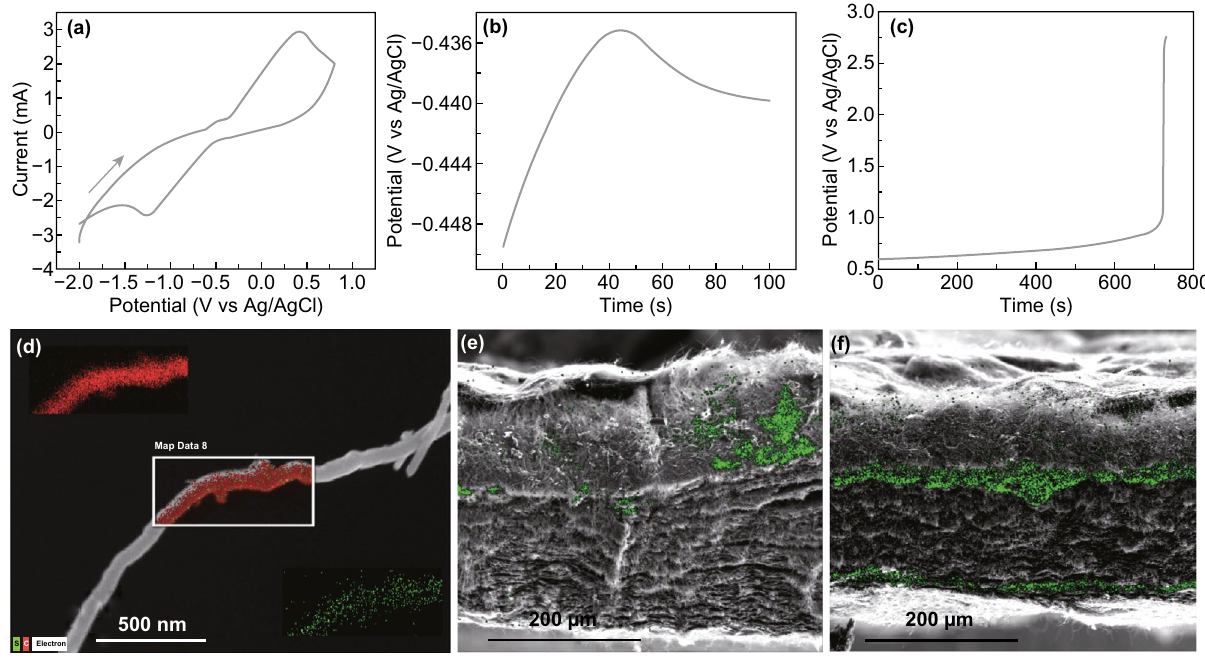
Fig. 1 a CV of 10 mM polysulfide using a BP electrode at 20 mV s −1 scan rate. Chronopotentiometry of sulfur electrodeposition on BP elec- trode at b 10 mA cm −2 and c 35 mA cm −2 . d EDS mapping of sulfur (green) and carbon (red) of a single nanotube of S/BP. Overlay of EDS sulfur mapping on the SEM image of the cross section of e S/BP-EtOH and f S/BP. The upper side of the BP corresponds to the side oriented to the counterelectrode during